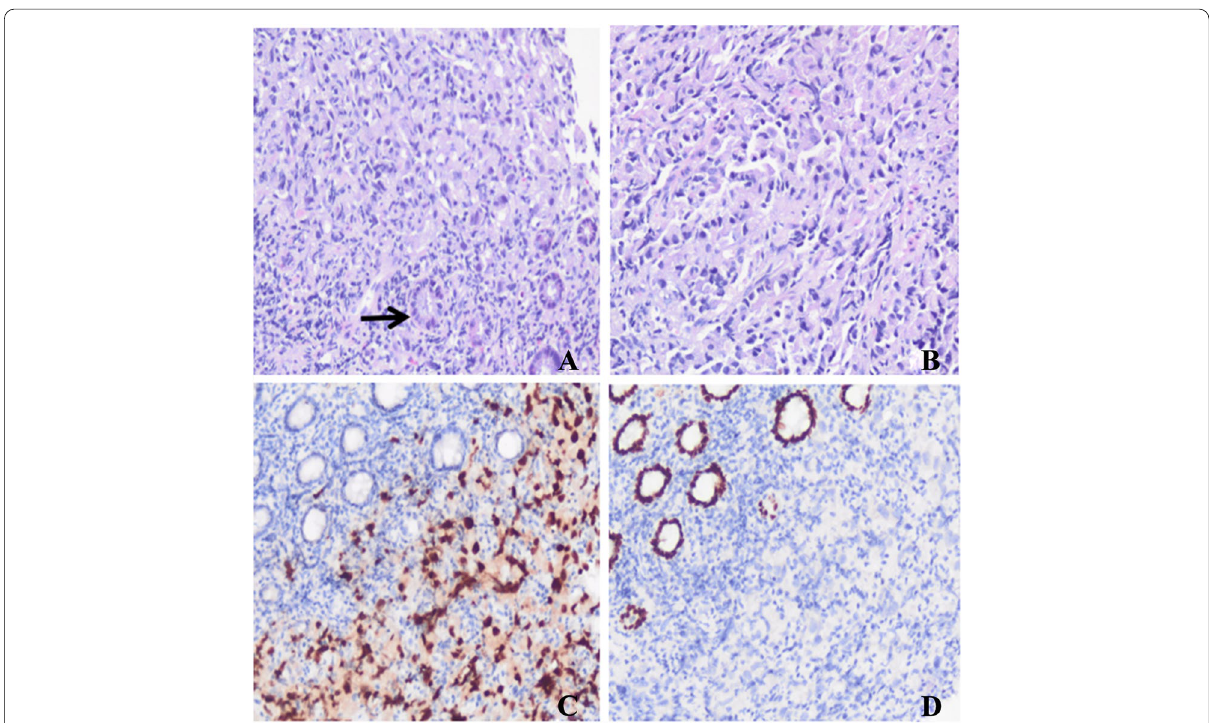
Fig. 5 H&E and immunohistochemical (IHC) staining of the tumour at the anastomotic site (magnification ✕ 200). A and B H&E staining of the tumour, and normal rectum mucosa epithelium (black arrow head). C Strong positive expression of NKX3.1 in cancer cells. D Negative for CDX-2 in cancer